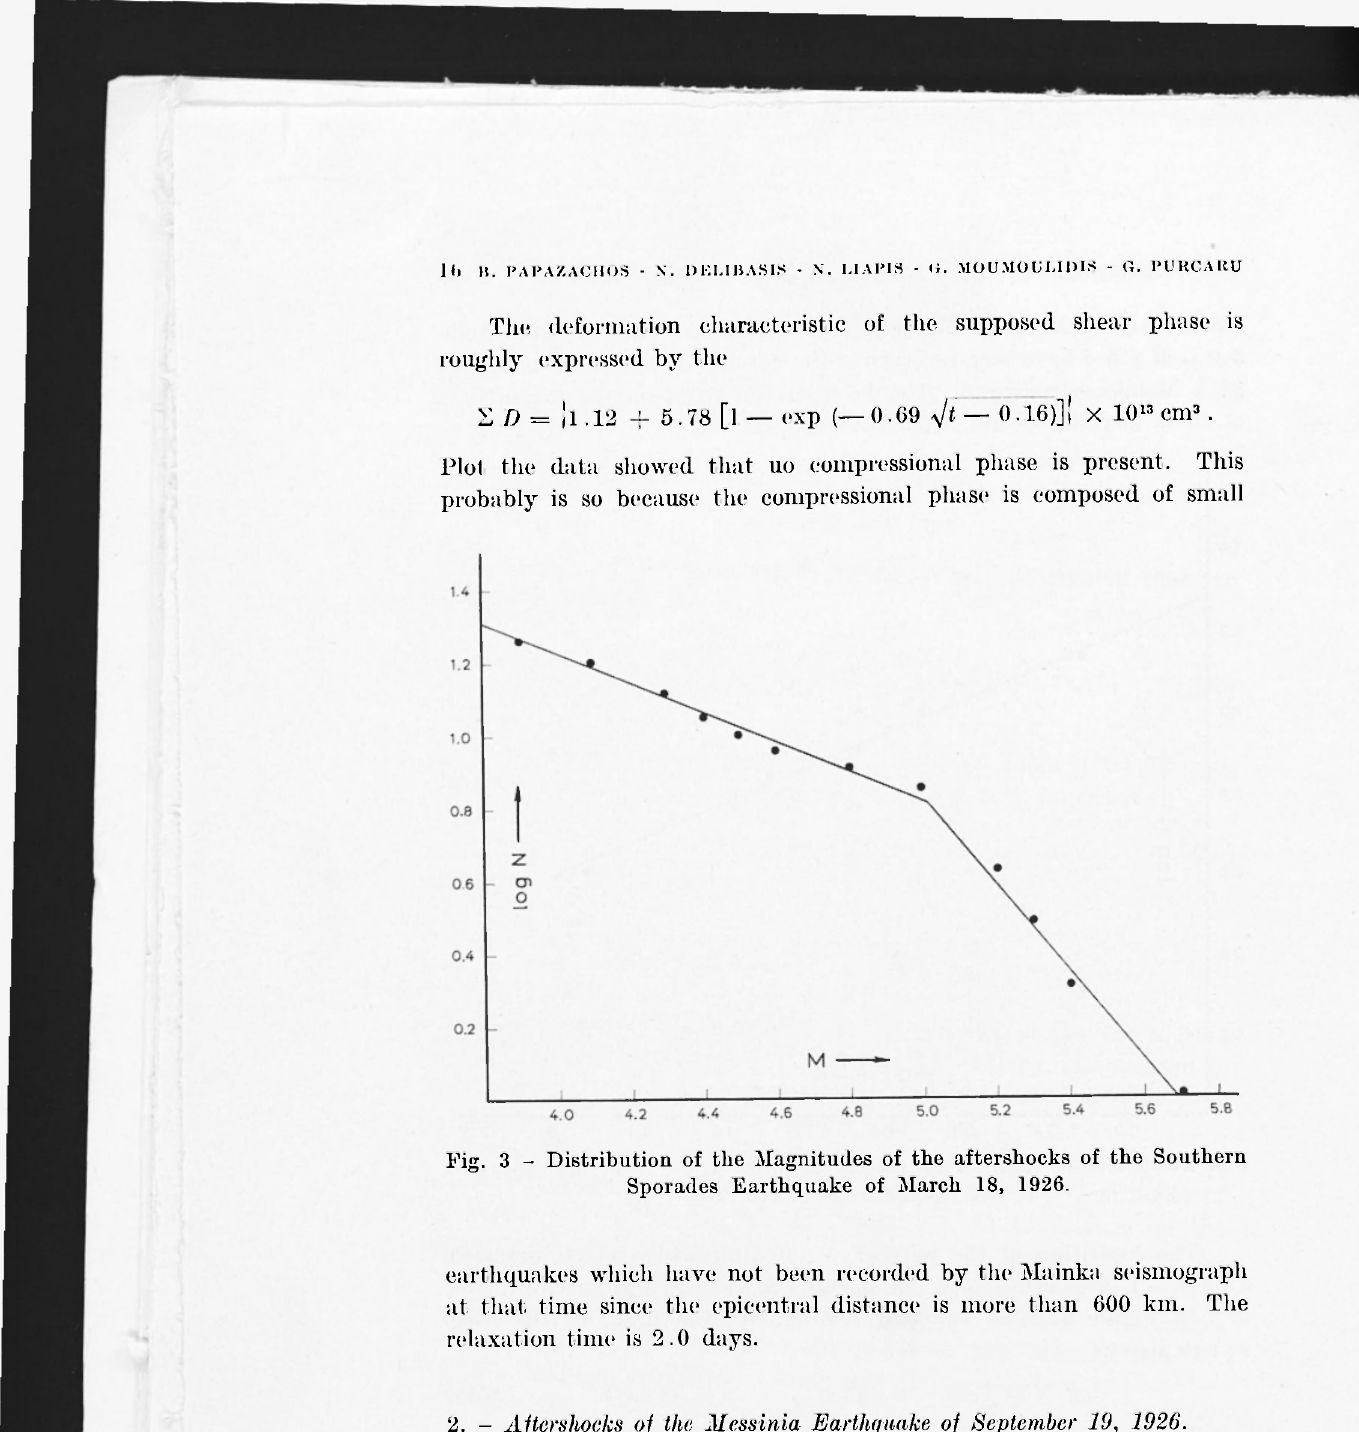
Fig. 3 - Distribution of the Magnitudes of the aftershocks of the Southern Sporades Earthquake of March 18,